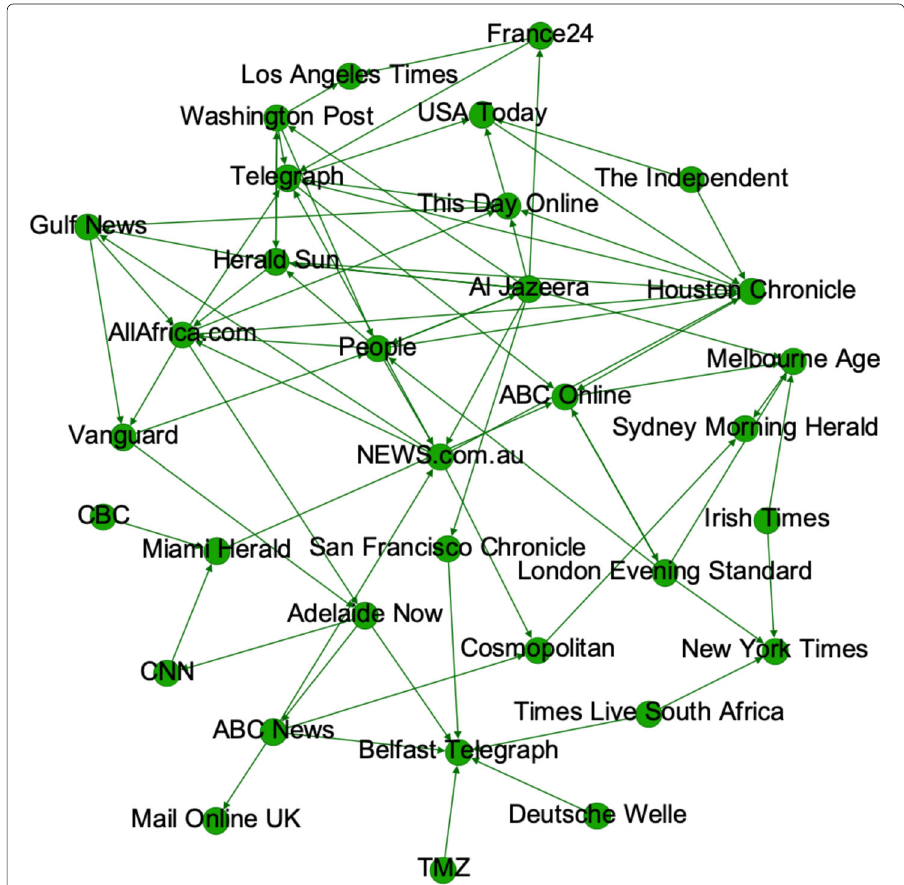
Fig. 2 An example of the intermedia influence networks for a topic about the 2016 US presidential election. Each node is an agent within the news media and an edge exists going from an influencer to an